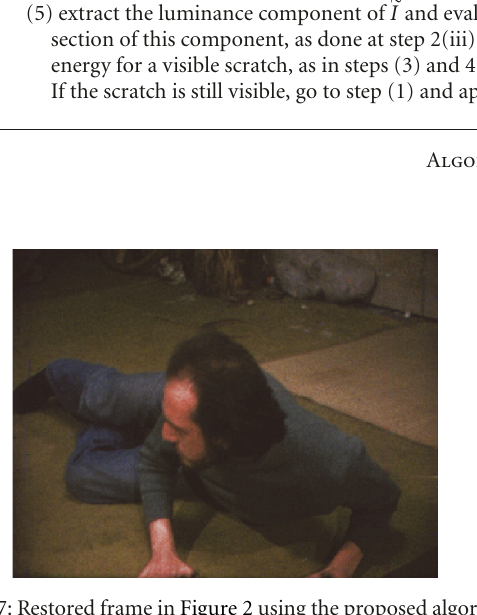
(3), C 1 = (1 − (1 − γ ) e ( − 2 /m ) | y − c p | ), C 2 = (1 − γ ), and D